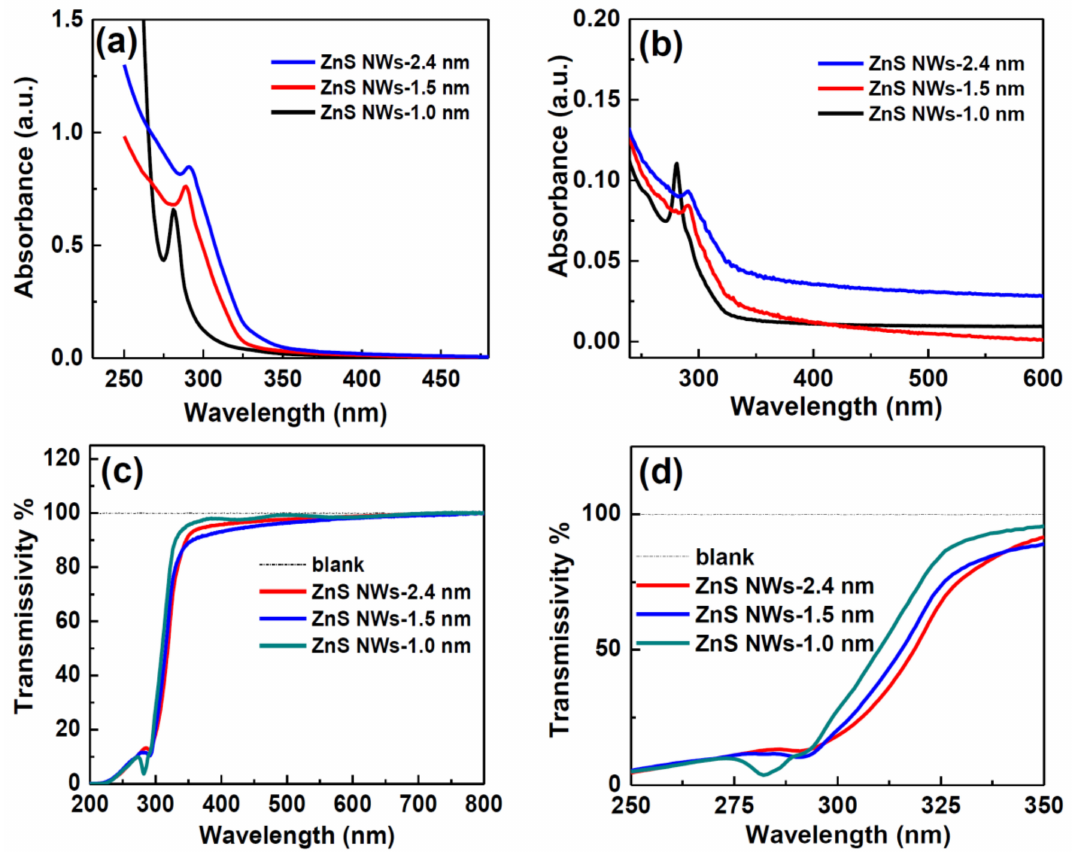
Figure 4. UV-vis absorption spectra of the as-prepared ZnS USNWs of different diameters dispersed in solution (chloroform) ( a ) or spin-coated on quartz sheets ( b ); ( c ) transmission spectra of the three ZnS NW films spin-coated on quartz sheets, ( d ) is a magnified view of the UV region displayed in ( c